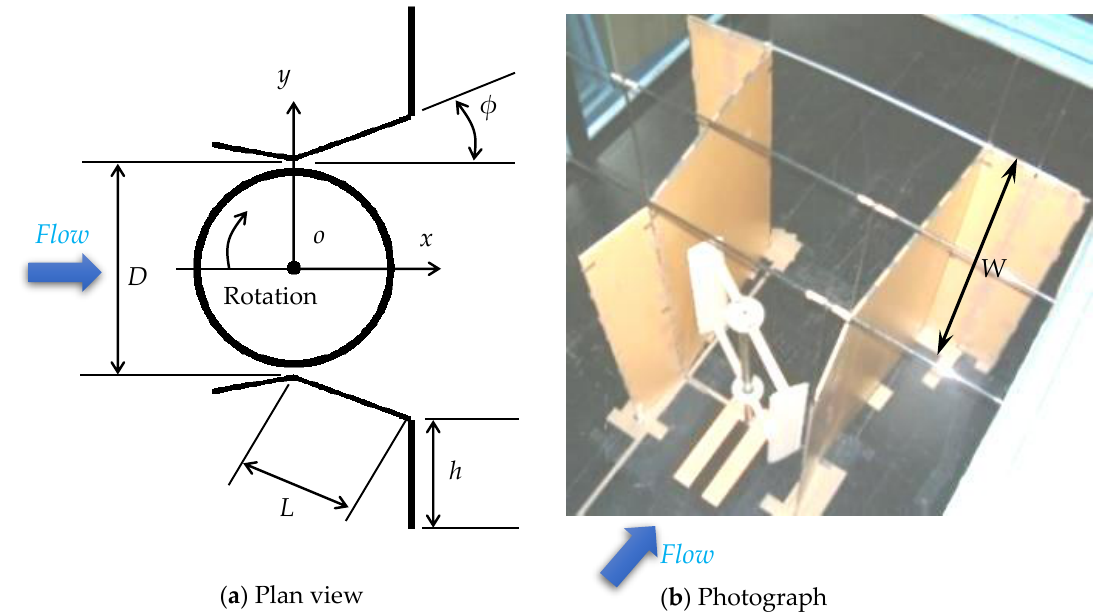
Figure 2. Configuration of the wind lens: ( a ) plan view (the height of the wind lens is W ); and ( b ) in situ photograph ( L = 1.14 D m, φ = 10°, h = 0.5 D m).